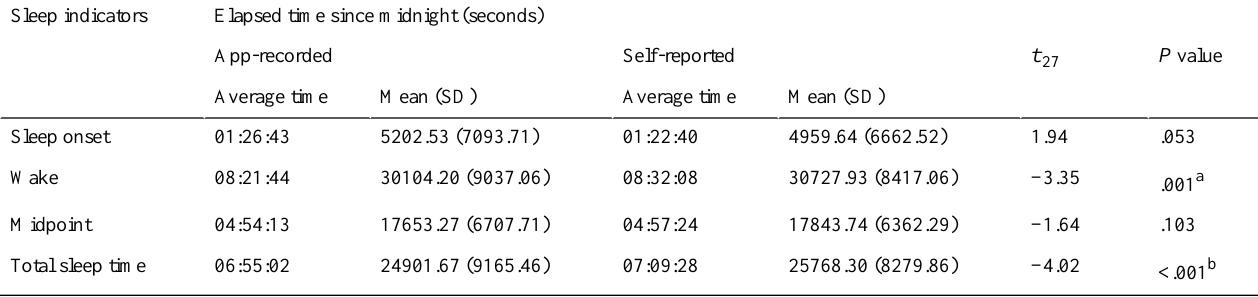
Table 1. The consistency between app-recorded and self-reported sleep indicator.